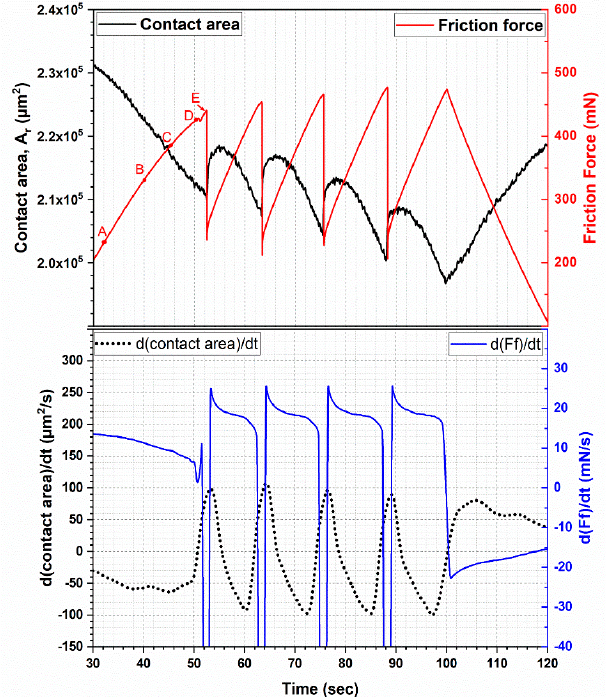
Figure 10. Upper: Change of contact area and friction force within the stick-slip behavior of the first trace in the 5 µm/s test; Lower: Changing rate of contact area and friction force within the stick-slip behavior of the first trace in the 5 µm/s test.